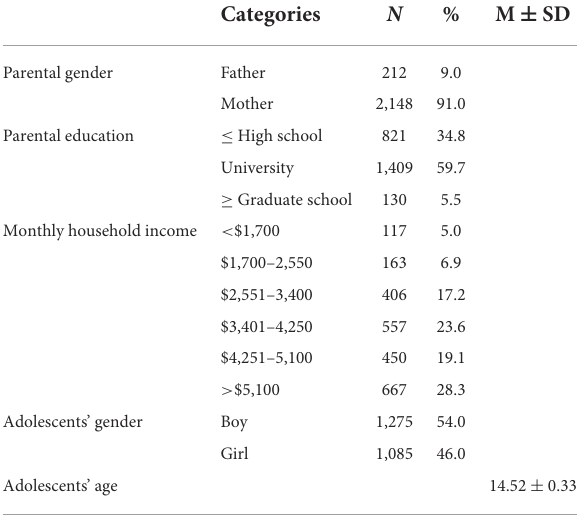
TABLE 1 Sociodemographic characteristics ( n =